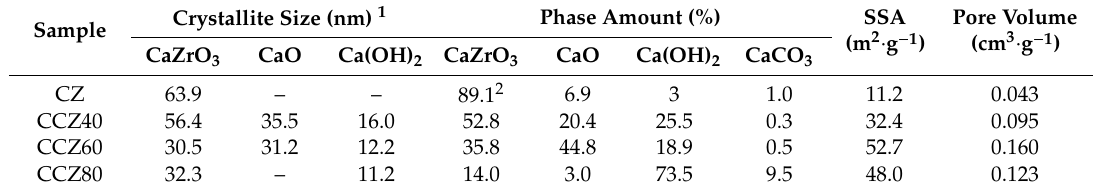
Table 1. Crystallite size, phase amount, and textural properties of as–prepared